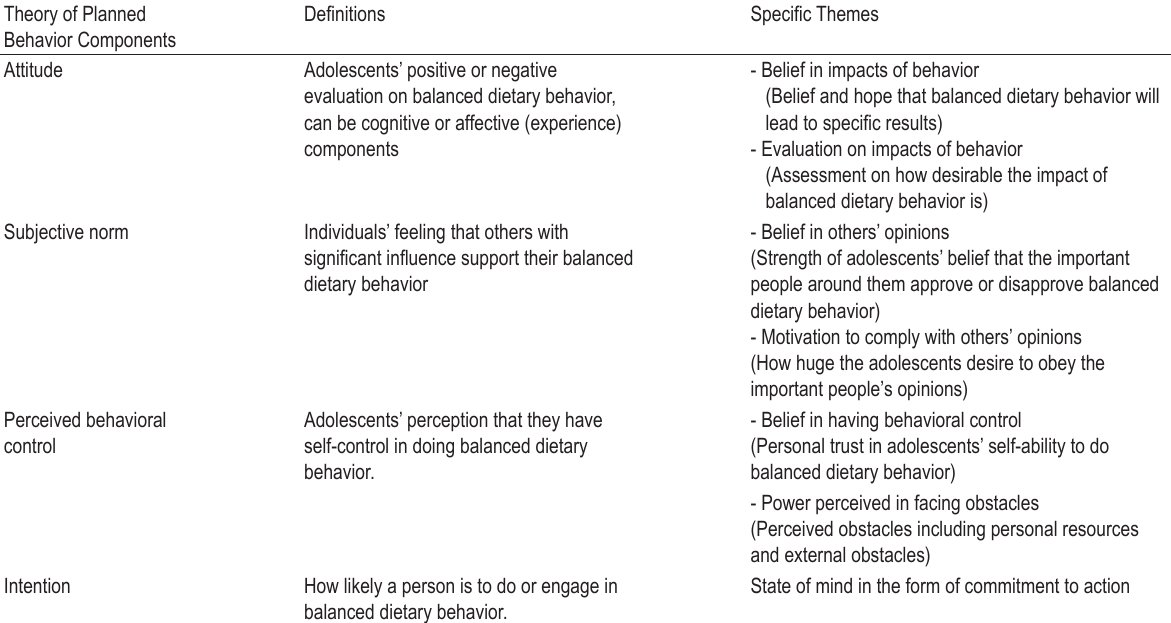
TABLE 1. The specific themes of the theory of planned behavior components expected to be assessed by the questionnaire Theory of